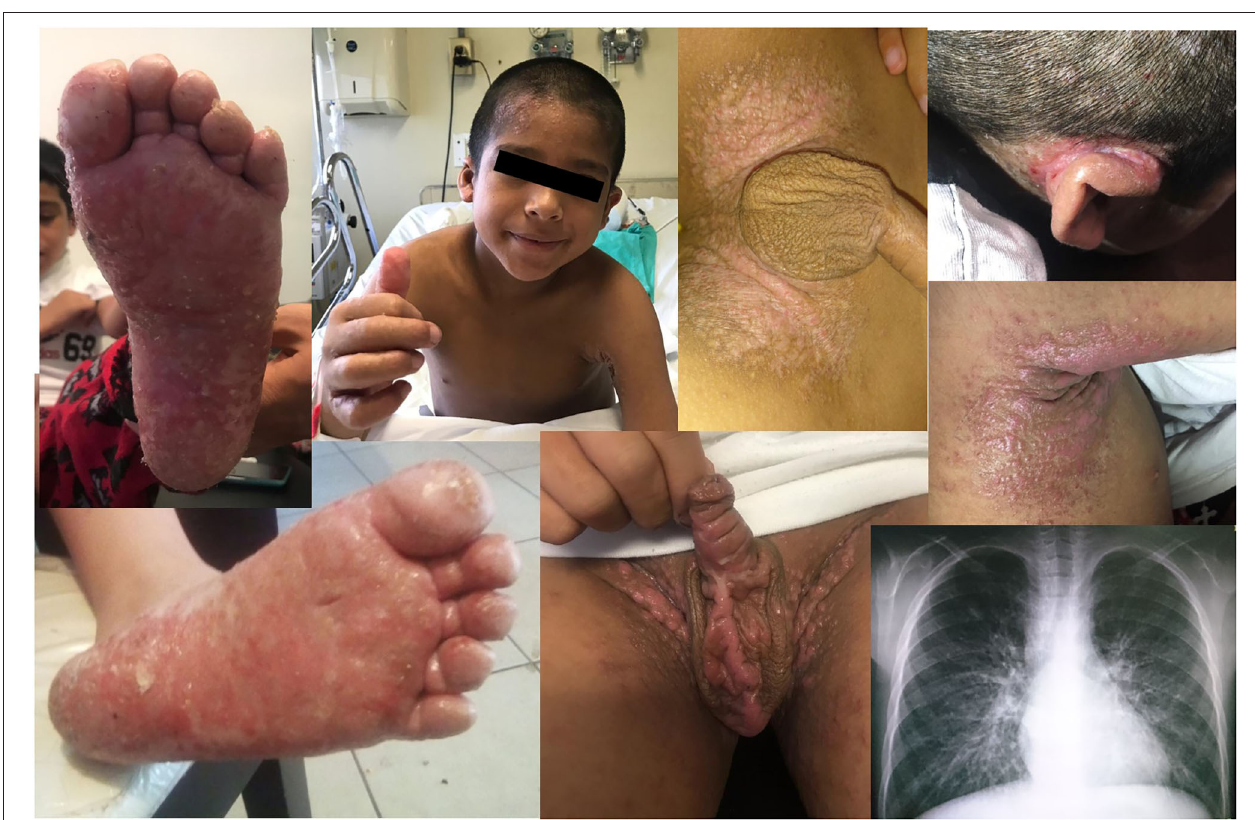
FIGURE 1 | Some clinical features of DOCK8 deficiency. Plain warts and discolored skin patches in forehead, trunk, hands, and soles. Severe retroauricular and axillar eczema. Lower right corner: chest radiograph showing bilateral bronchiectases and perihilar interstitial